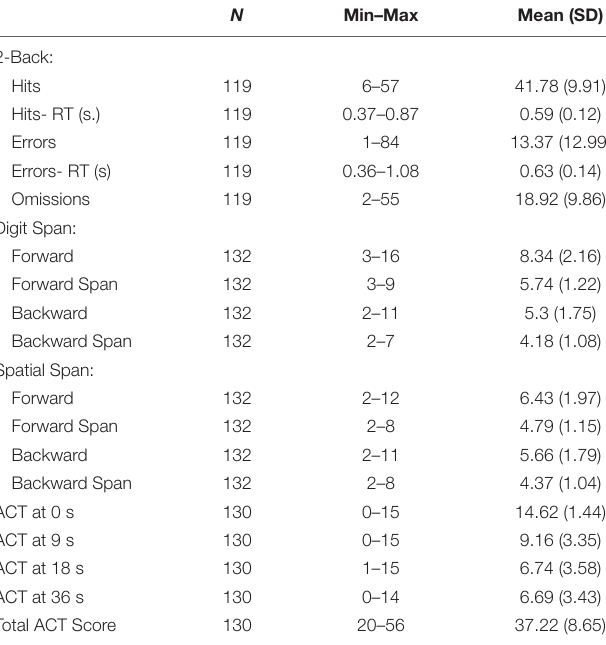
TABLE 2 | Descriptive statistics of patients performance on working memory